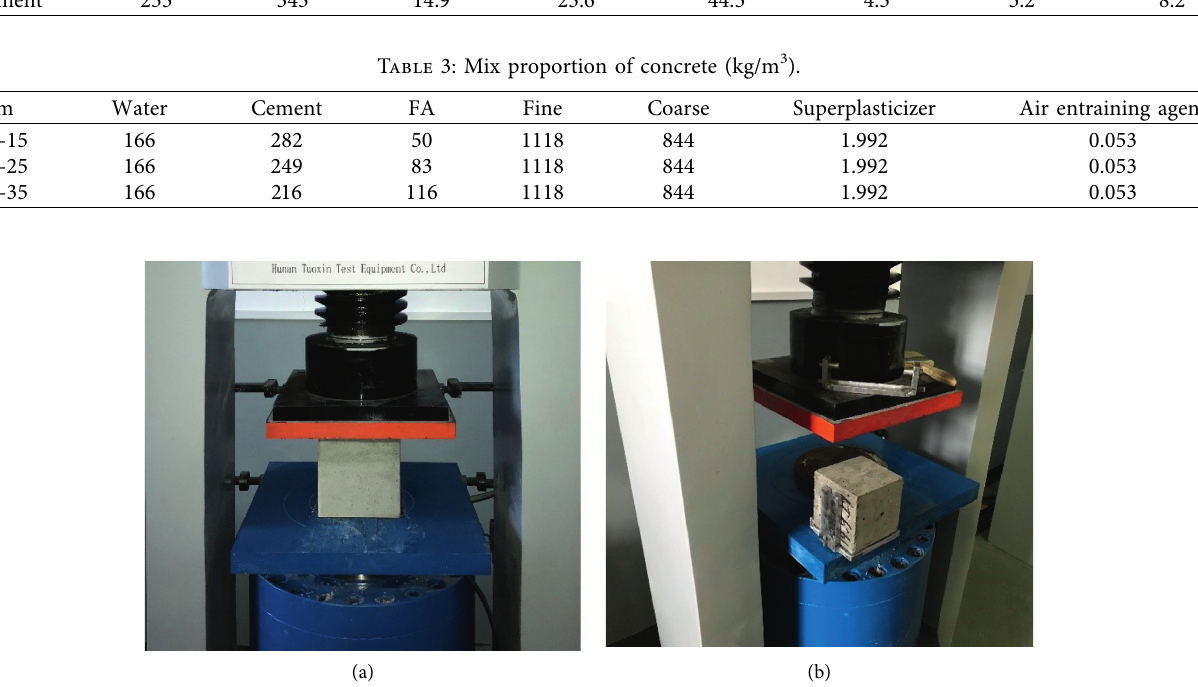
Figure 1: Mechanical property test: (a) compression test; (b) splitting tension test.